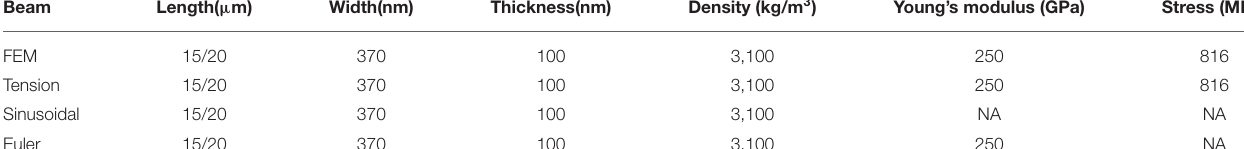
TABLE 2 | Parameters used in the analytical models and FEM simulations.